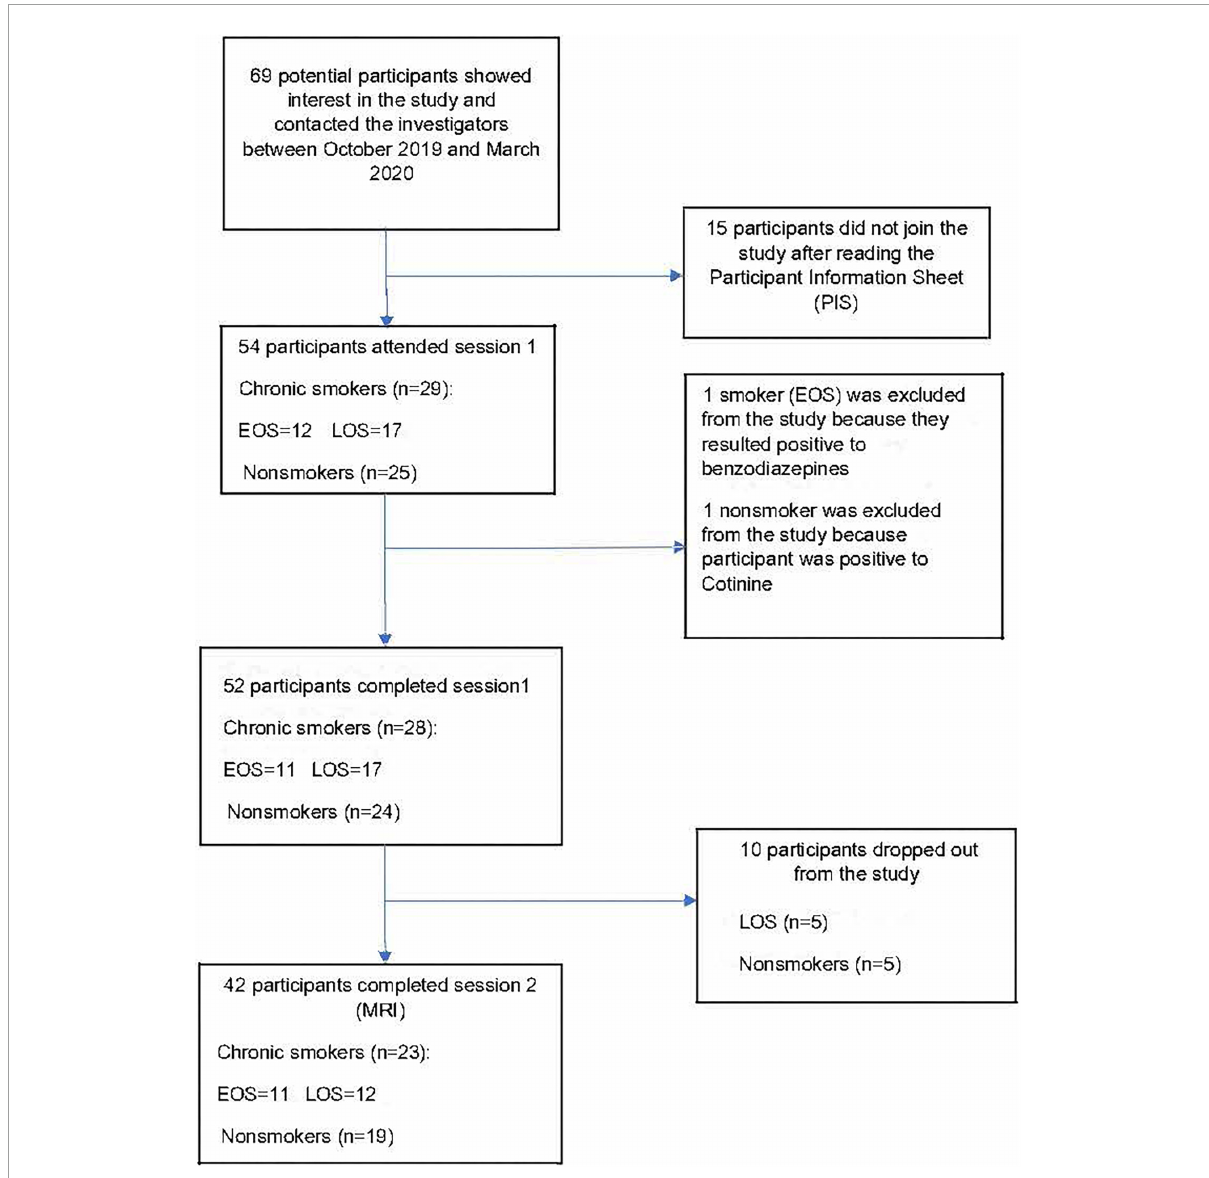
FIGURE1 Recruitment flowchart between October 2019 and March 2020. EOS, early onset smokers; LOS, late onset smokers. Figure adapted from “Neuroanatomical correlates of impulsive choices and risky decision making in young chronic tobacco smokers: A voxel-based morphometry study”